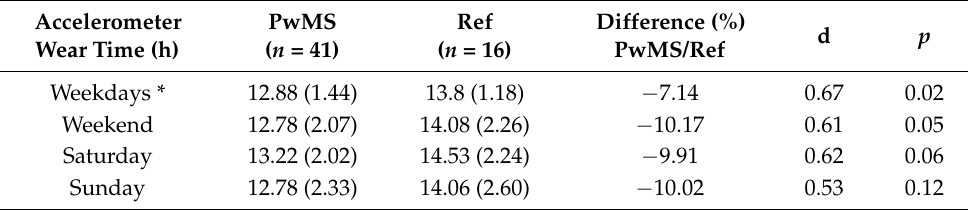
Table 2. Means and (SD) of participants’ accelerometer wear time on weekdays, weekend and Saturday and